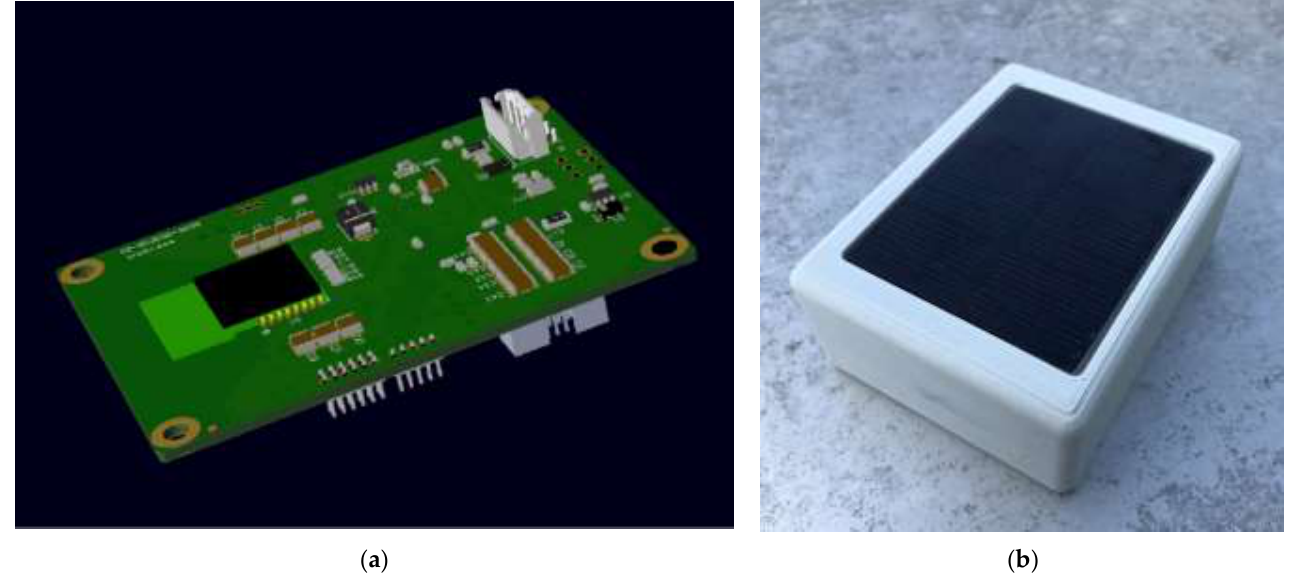
Figure 3. Developed sensor node: ( a ) 3D render of the designed electronic board and ( b ) first prototype of WindNode [1] © 2020 IEEE.